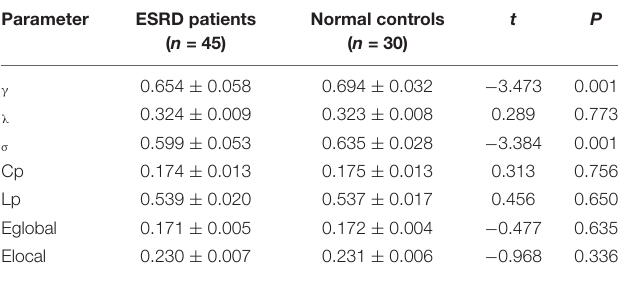
function of patients with ESRD. For patients with ESRD patients, the AUCs of γ and σ were positively correlated with the scores of the cognitive function ( p < 0.0033, Bonferroni correction), while